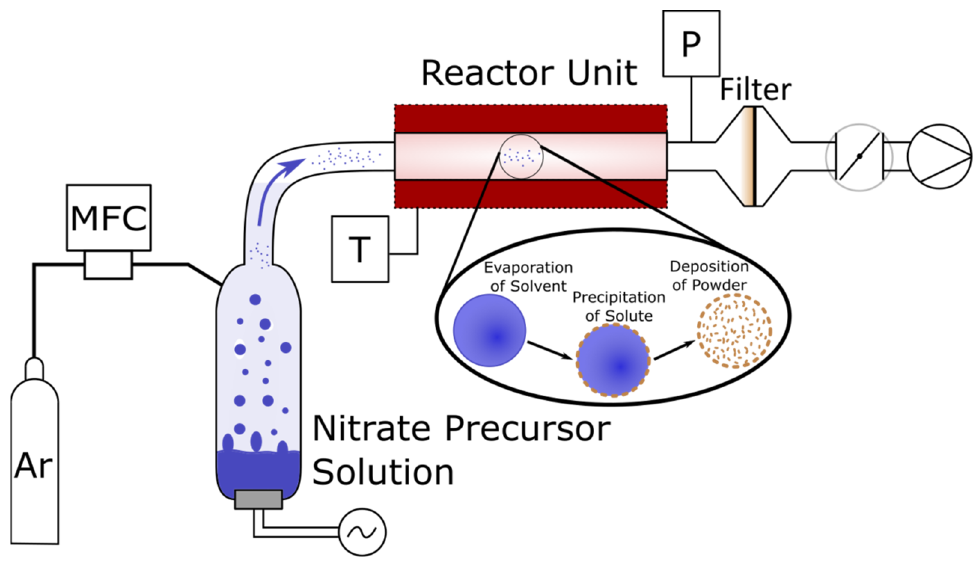
Figure 2. NSP experimental setup with the schematical precipitation process.